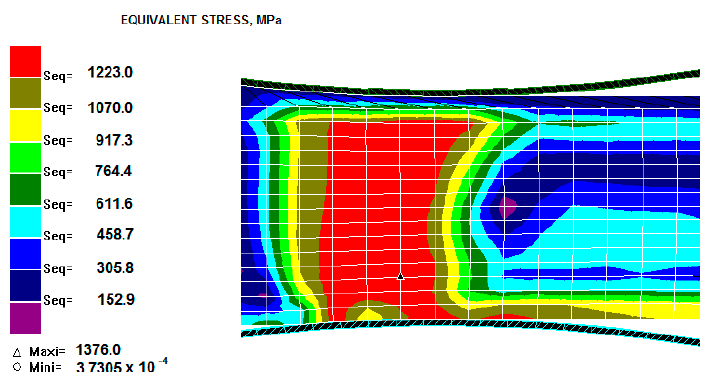
Figure 6. State of equivalent stress for the Ni–5%Al alloy coating for 5% relative draft with different coating thicknesses at the upper part rolling band h p = 0.6 mm.